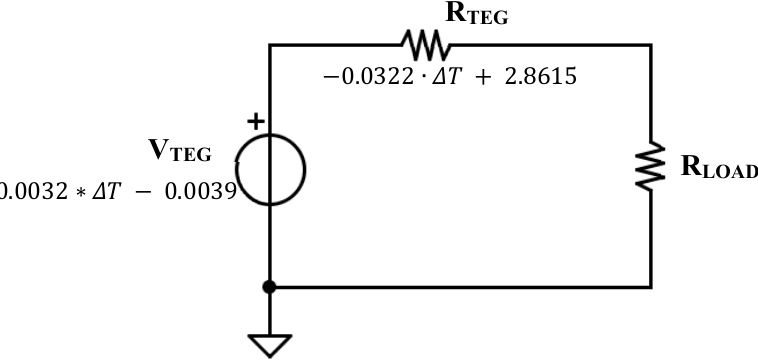
Figure 6. Identified SPICE (Simulation Program with Integrated Circuit Emphasis) model of the single TEG cell.